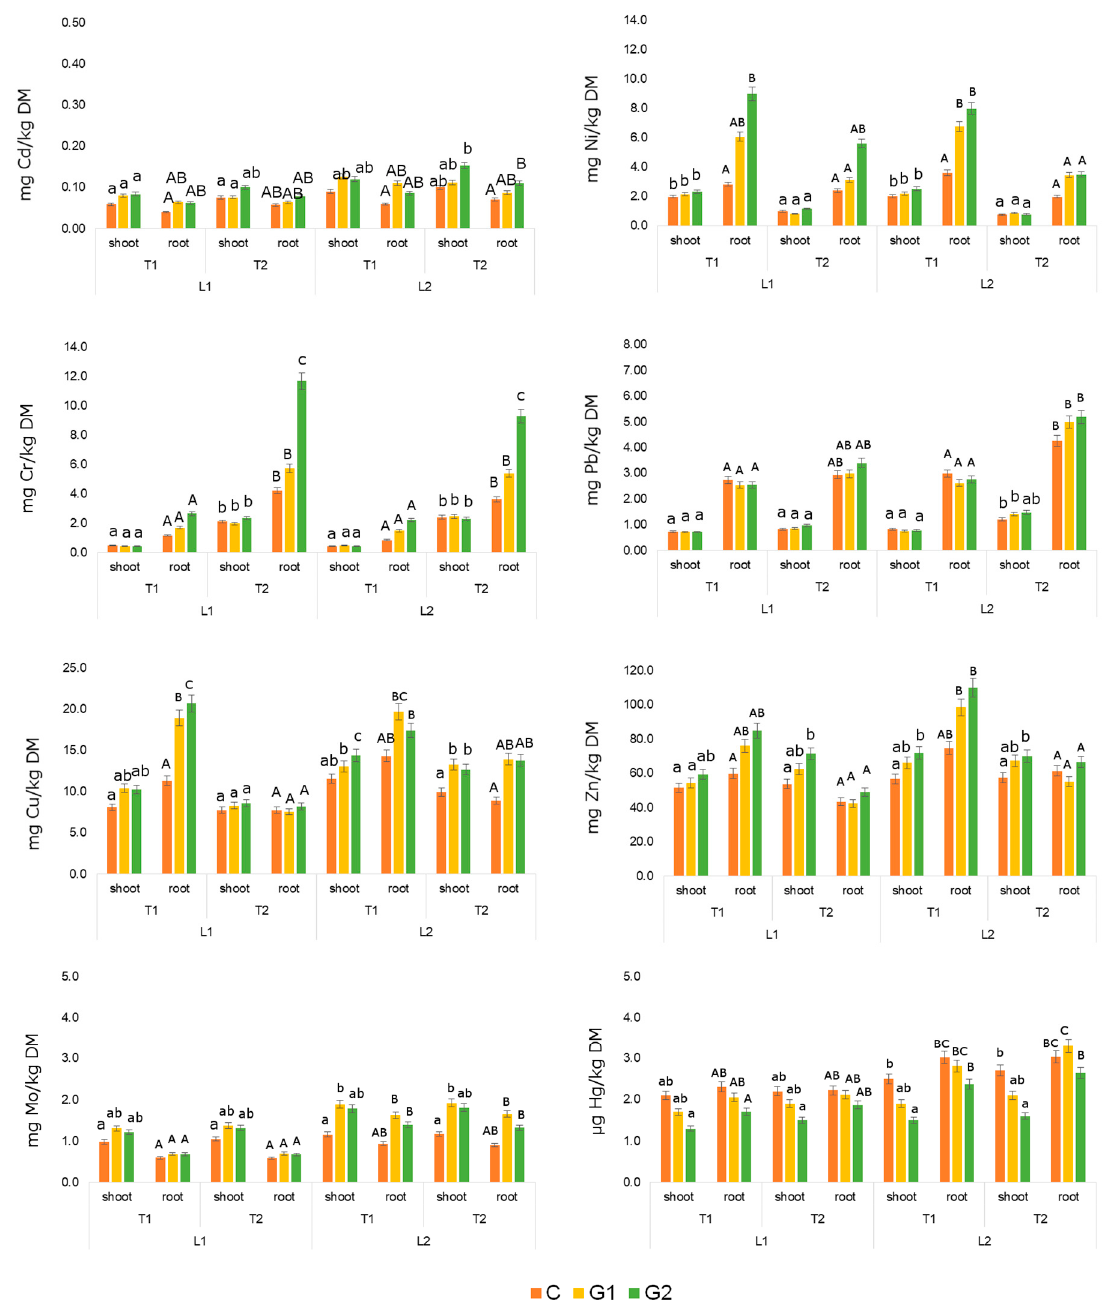
Figure 5. The average content of HMs (Cd, Cr, Cu, Mo, Ni, Pb, Zn, and Hg) in shoot and root of grass mixture samples from the control plots (C) and plots fertilized with sewage sludge in a dose of 14.5 t DM/ha (G1) and 29 t DM/ha (G2) in L1 and L2, collected in first (T1) and second (T2) year of study. Different letters (small letters—shoot, capital letters—root) above bars (mean ± SD) represented significant differences assessed with the Tukey test at p < 0.05.